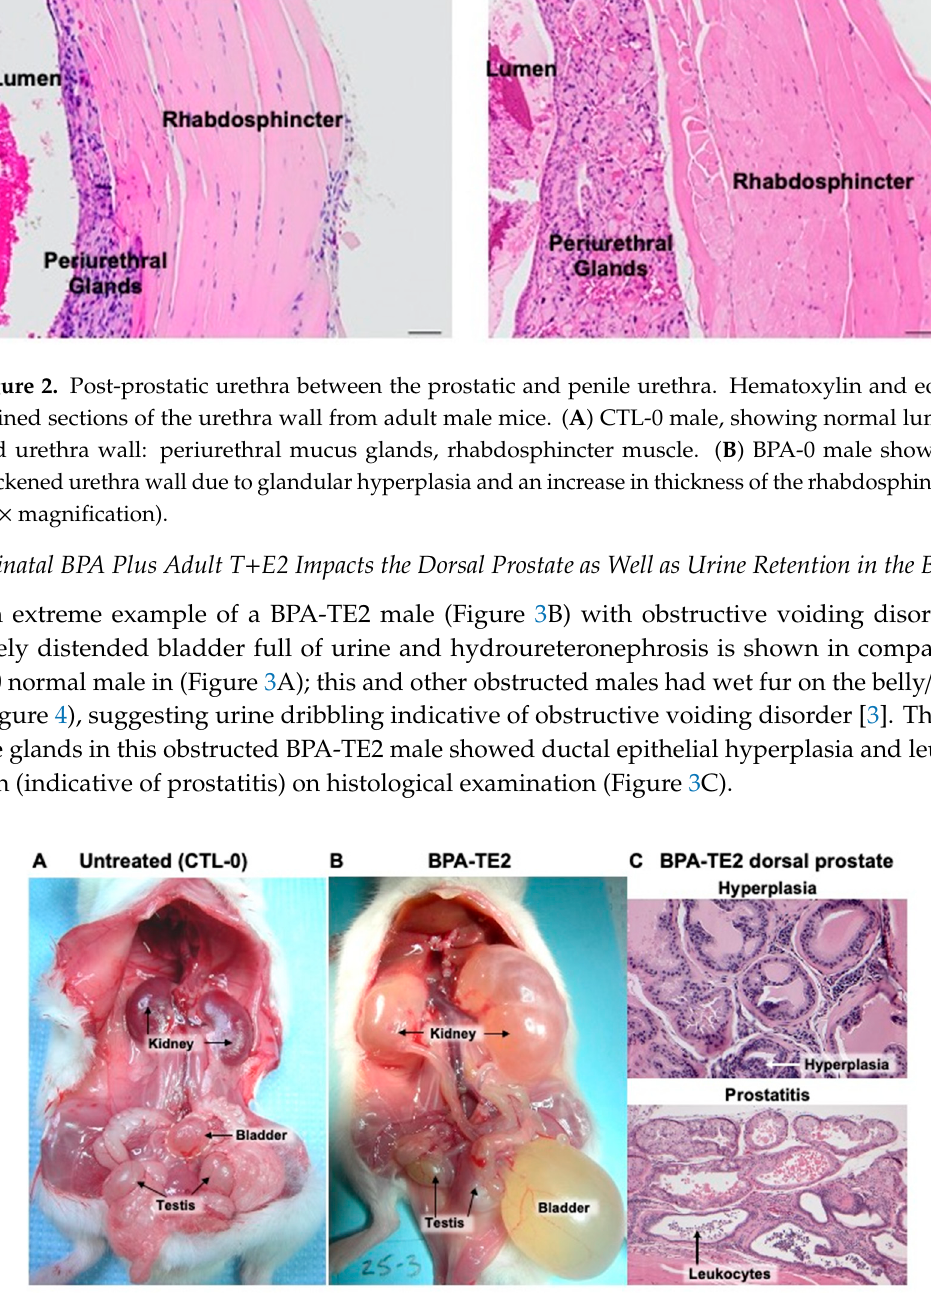
Figure 3. ( A ) Normal urogenital system in a perinatal control male mouse treated in adulthood with an empty capsule (CTL-0). ( B ) Bladder obstruction and hydronephrosis in an animal exposed perinatally to bisphenol A (BPA) and given testosterone and estradiol (T+E2) treatment in adulthood, and ( C ) dorsal prostate (with hematoxylin and eosin staining) showing epithelial hyperplasia and leukocyte infiltration of prostatic ducts (indicative of prostatitis) in the same BPA-TE2 animal shown in B (40× magnification).